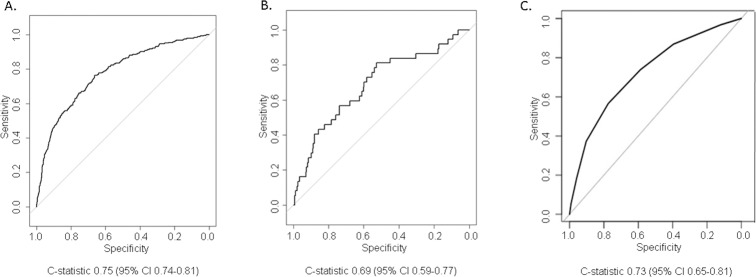
Receiver operator characteristic curves of model predictions of mortality within 1 year of starting ART in the derivation cohort (A), validation cohort (B), and when a simplified risk score is used in the derivation cohort (C).